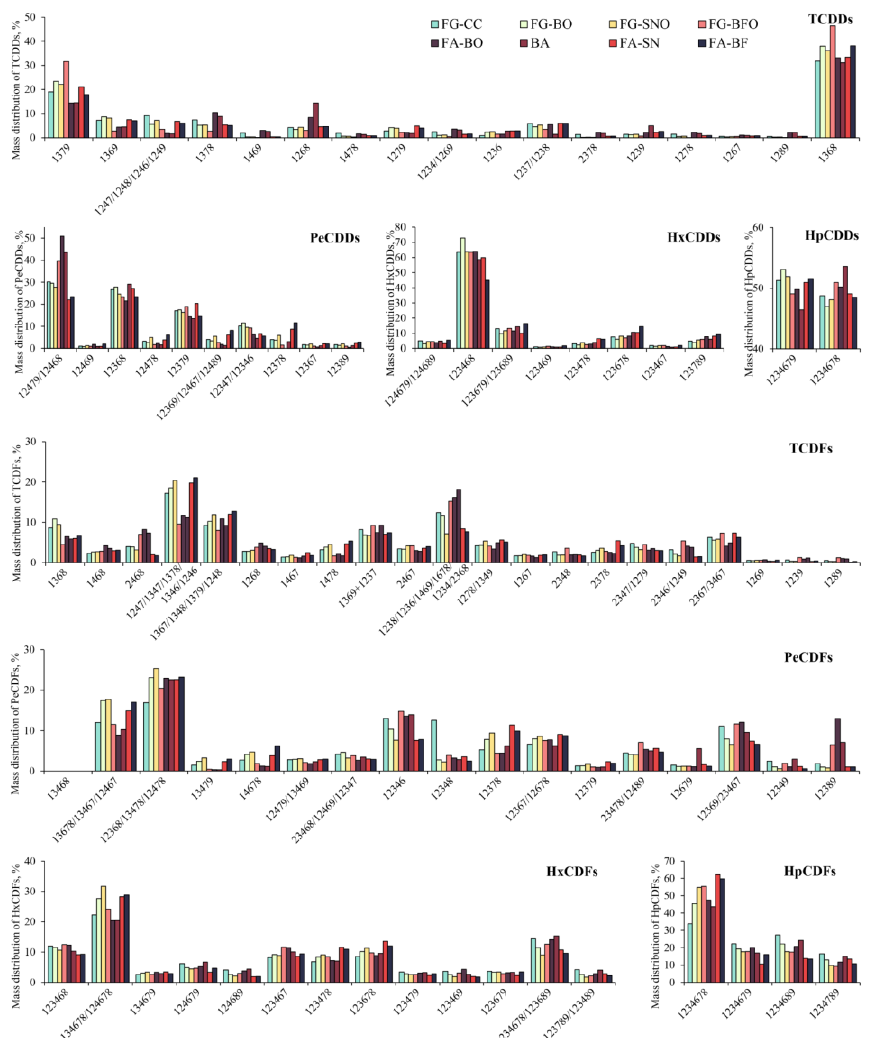
Figure 4. Distribution of 136 kinds of tetra-through octa-chlorinated PCDD/F isomers.